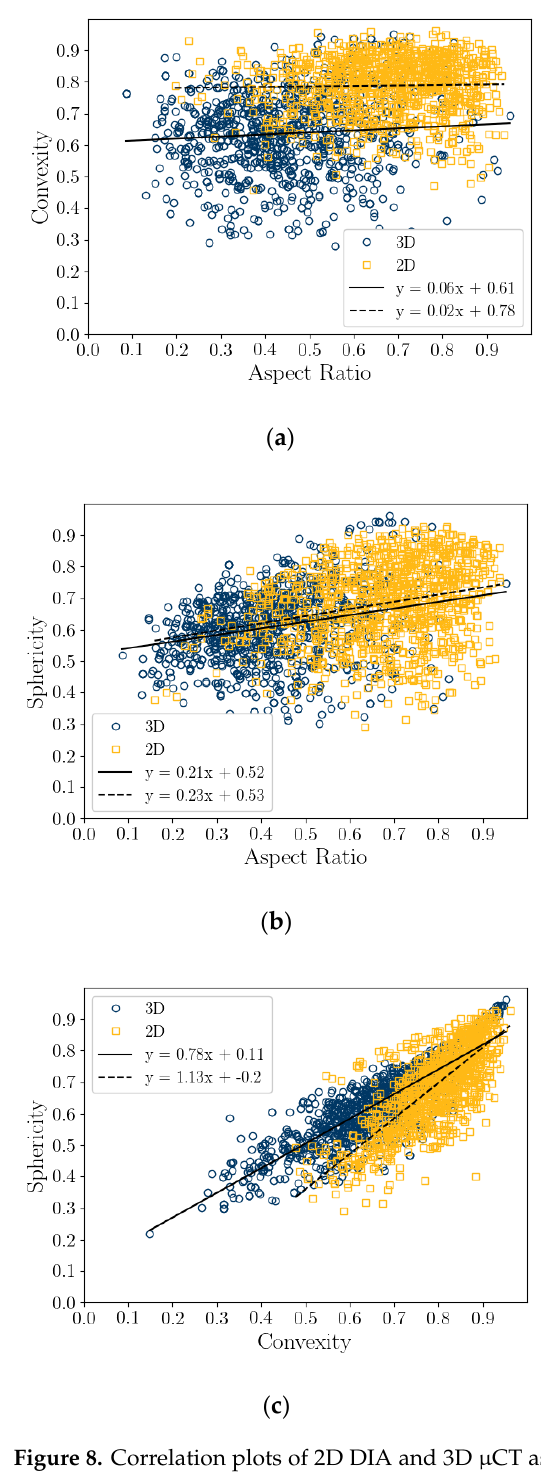
Figure 8. Correlation plots of 2D DIA and 3D μ CT aspect ratio, convexity, and sphericity for 1000 randomly selected particles. Convexity versus aspect ratio ( a ), sphericity versus aspect ratio ( b ), and sphericity versus convexity ( c ).